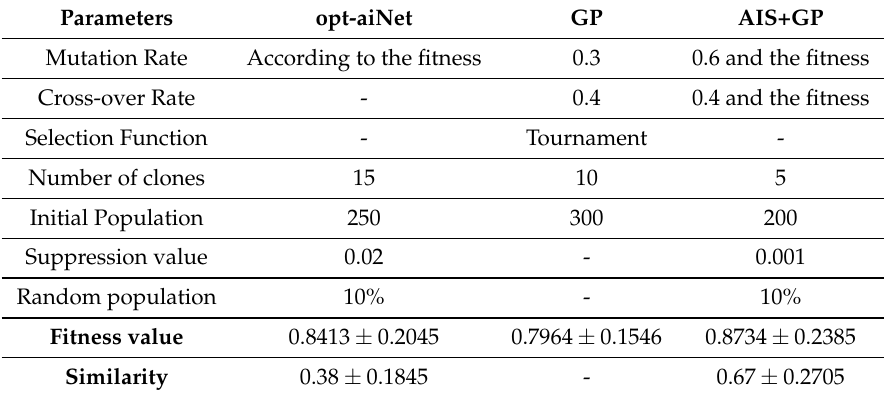
Table 2. Results of the objective function for three different configurations of the